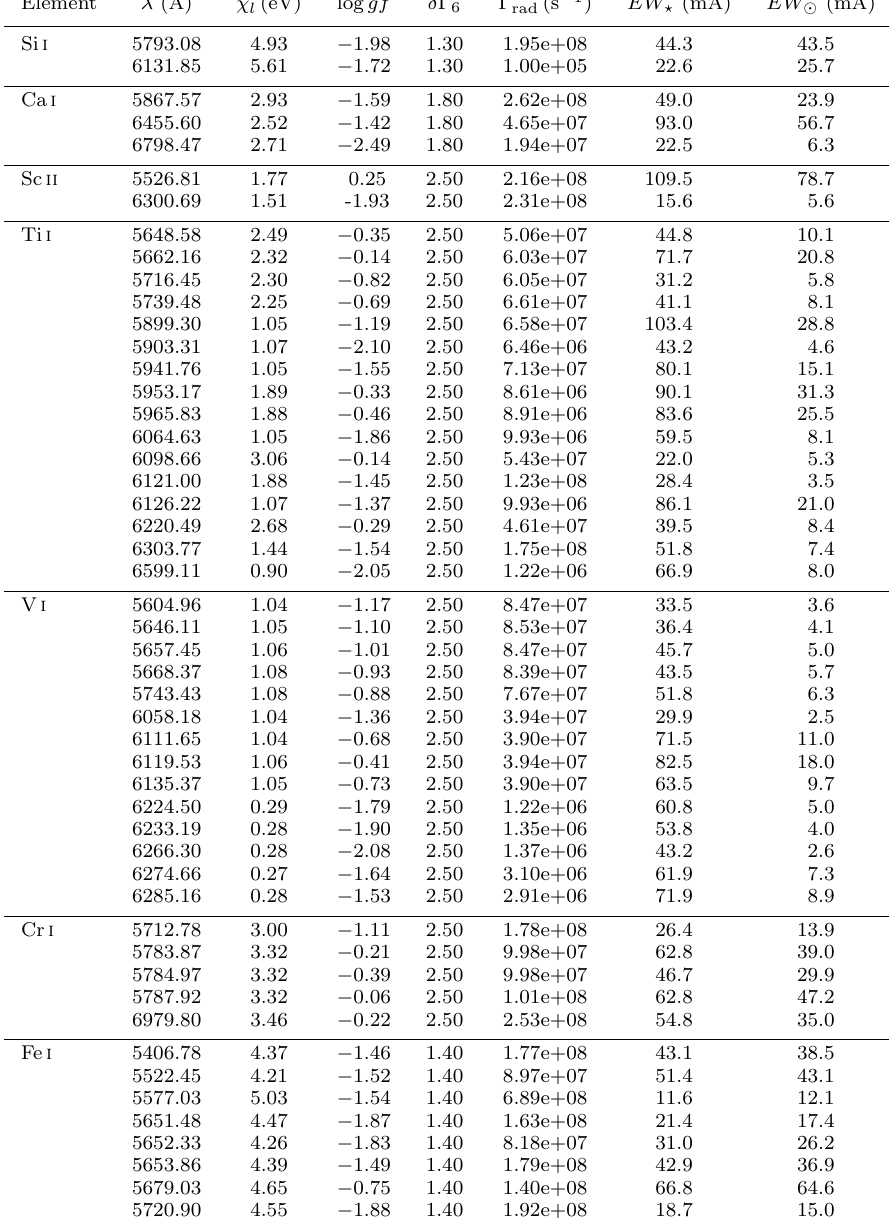
Table 1. Atomic line data and the measured equivalent widths. In the head of the table (cid:31) l is the excitation potential of the lower level, log gf is the oscillator strength, (cid:14) Γ 6 is the correction factor to the van-der-Waals damping constant, Γ rad is the radiation damping constant, EW ⋆ and EW ⊙ are the equivalent widths of lines in (cid:21) And and in the solar